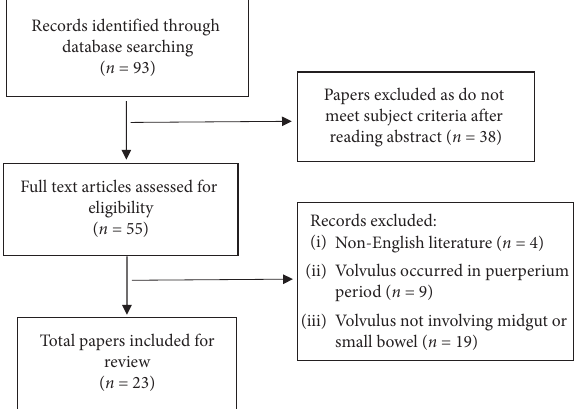
Figure 1: Search